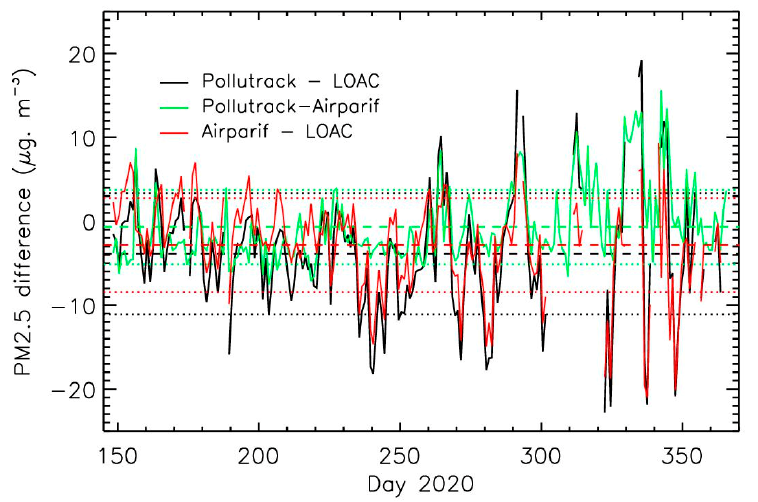
Figure 5. Temporal evolution of the difference of the PM2.5 mass concentration for the 3 sets of measurements; the dashed line represents the mean and the dotted lines represent the standard deviation. Table 1. Statistics of the differences between the 3 sets of measurements for the PM2.5. Instruments